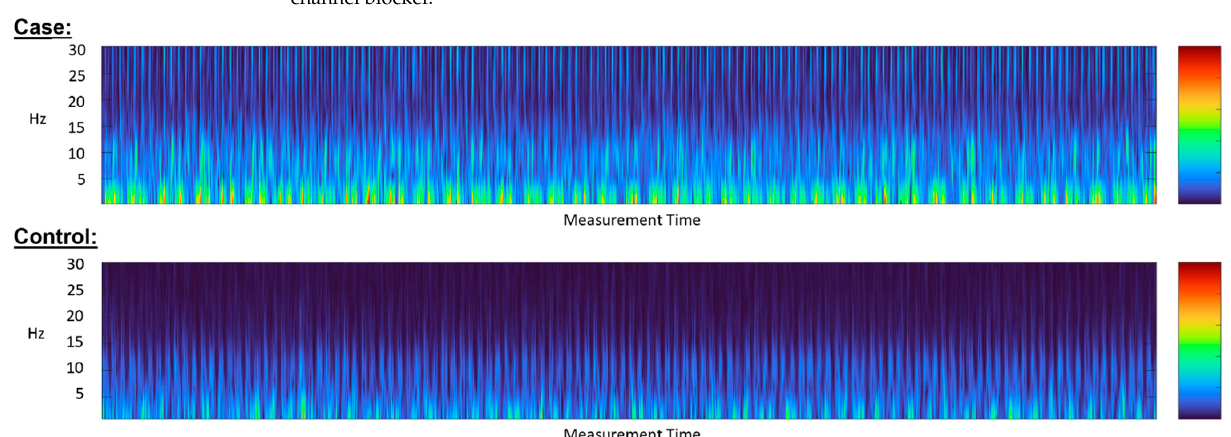
Figure 4. Representative spectrograms of signals. Table 1. Baseline characteristics of study population.